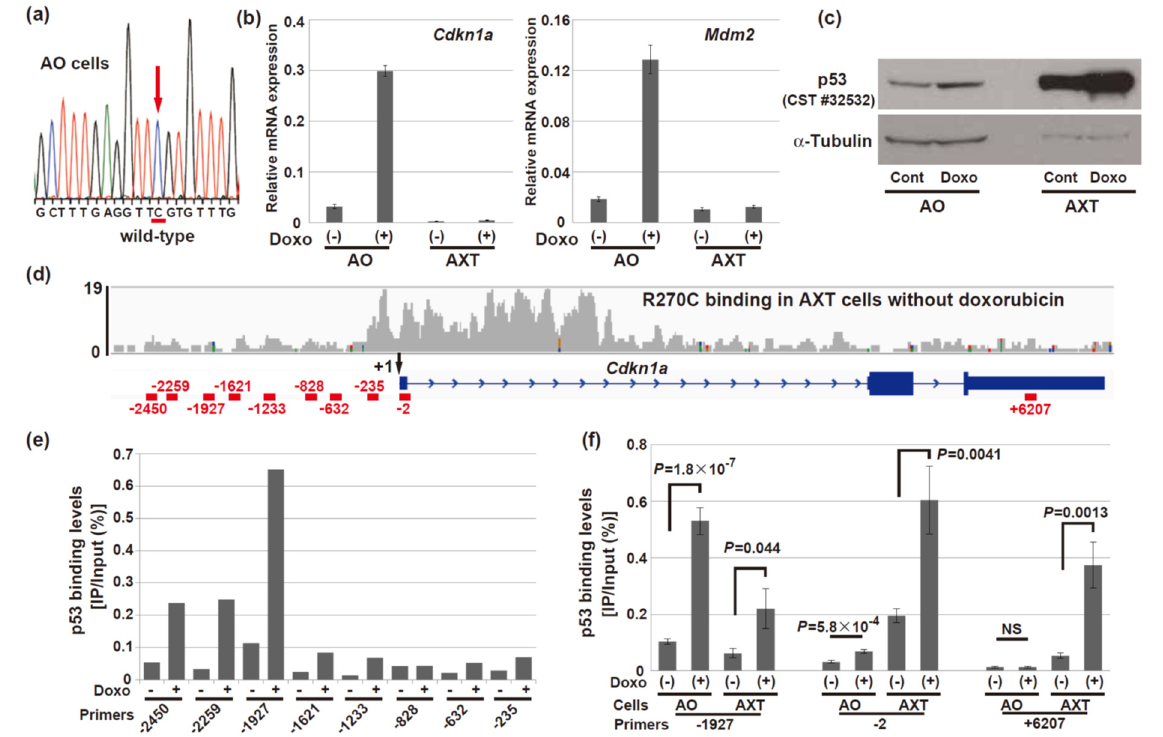
Figure 7. R270C mutant p53 exhibits a different DNA-binding profile from wild-type p53. ( a ) AO cells harbor wild-type p53. ( b ) RT and real-time PCR analysis of the Cdkn1a and Mdm2 mRNA in AO and AXT cells treated with or without 0.5 µM doxorubicin for 8 h. The data are normalized to the corresponding levels of Actb mRNA and are shown as the means ± SD of triplicate values. ( c ) Immunoblot analysis of p53 expression in AO and AXT cells with or without 0.5 µM doxorubicin for 16 h. ( d ) Map of the Cdkn1a gene locus showing the binding profile of R270C mutant p53 in AXT cells, the transcription start site (+1), and the location of ten amplicons used in real-time qPCR analyses. Numbers indicate the position of the 5’ end of the amplicon relative to the transcription start site. The snapshot image was taken from analysis using the IGV software. ( e ) Screening of the p53 binding levels of wild-type p53 in AO cells treated with or without 0.5 µM of doxorubicin for 8 h. The result of a single experiment is shown. ( f ) DNA binding levels of wild-type p53 or R270C mutant p53 were evaluated by ChIP-qPCR analyses. ChIP assays were performed with cell extracts obtained from AO or AXT cells treated with or without 0.5 µM doxorubicin for 8 h. The results shown are the means ± SE of nine independent PCRs of three independent experiments. (NS, not